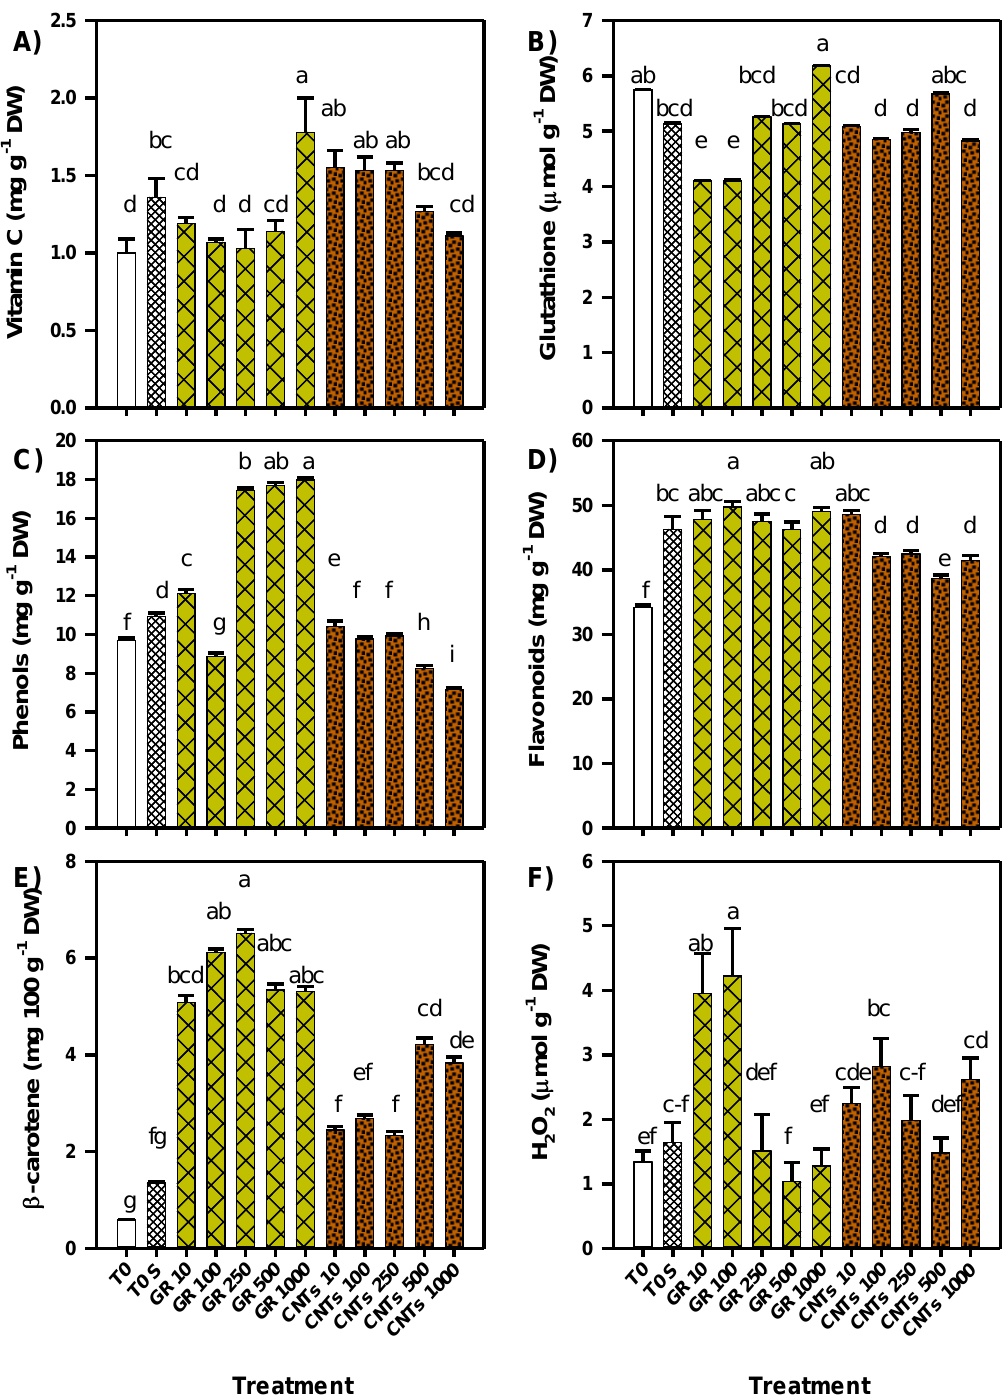
Figure 4. Antioxidant compounds and hydrogen peroxide (H 2 O 2 ) in the leaves of tomato seedlings treated with carbon nanomaterials. Each data point is the average of five replicates ± standard error. Different letters indicate significant differences between treatments according to Fisher’s least significant difference test ( p ≤ 0.05). T0: absolute control. T0 S: sonicated control. GR: graphene. CNTs: carbon nanotubes. DW: dry weight.